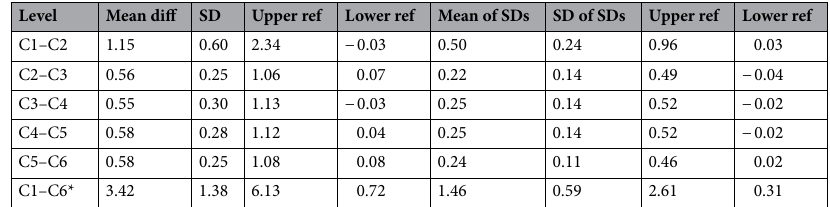
Table 2. Absolute differences between each of 4 continuous sequential motion tracks and their means (degrees) in population (n = 20). *Sum of Means and